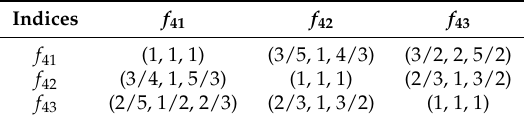
Table A4. Fuzzy comparison matrix of three